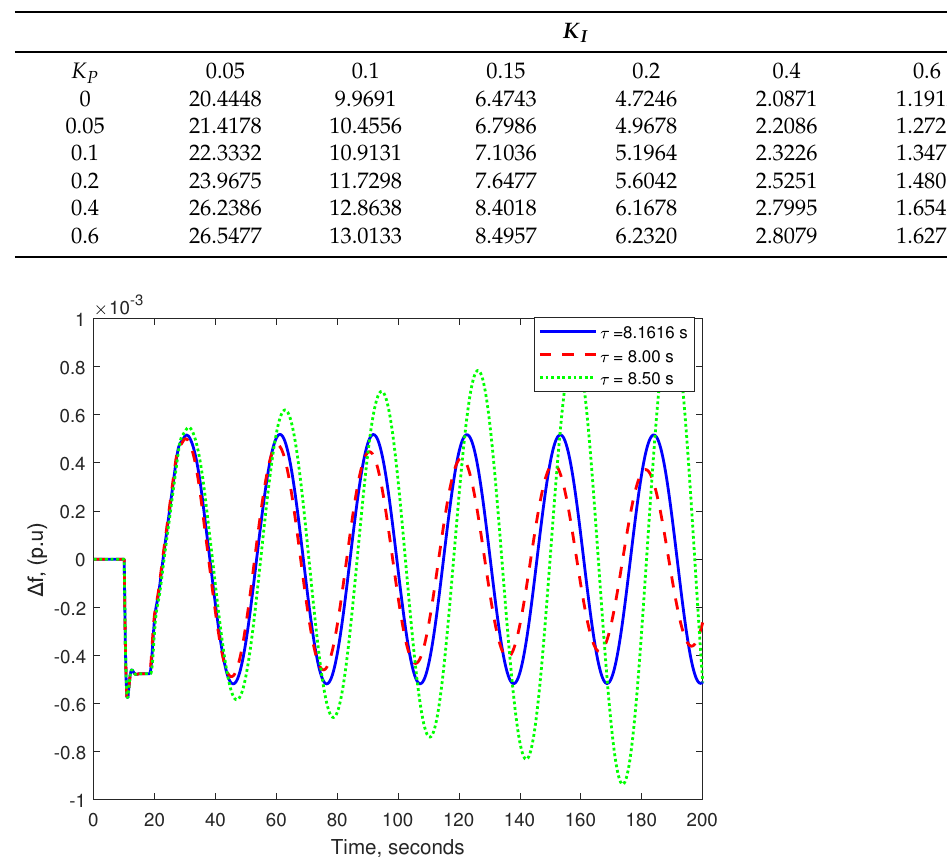
Table 6. Delay margin ( G m = 1, Φ m = 30 ◦ ).